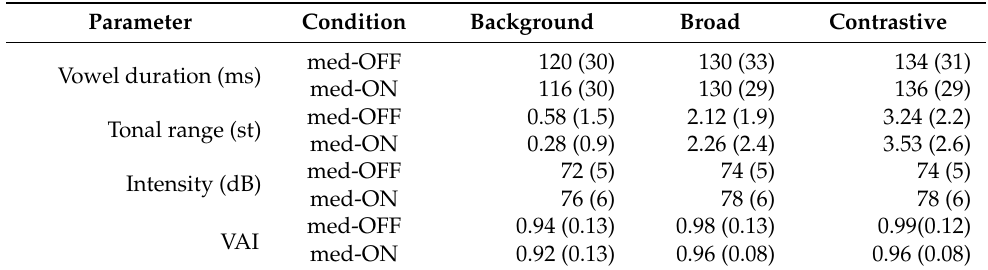
Table 3. Means and standard deviations for acoustic parameters of interest depending on prominence